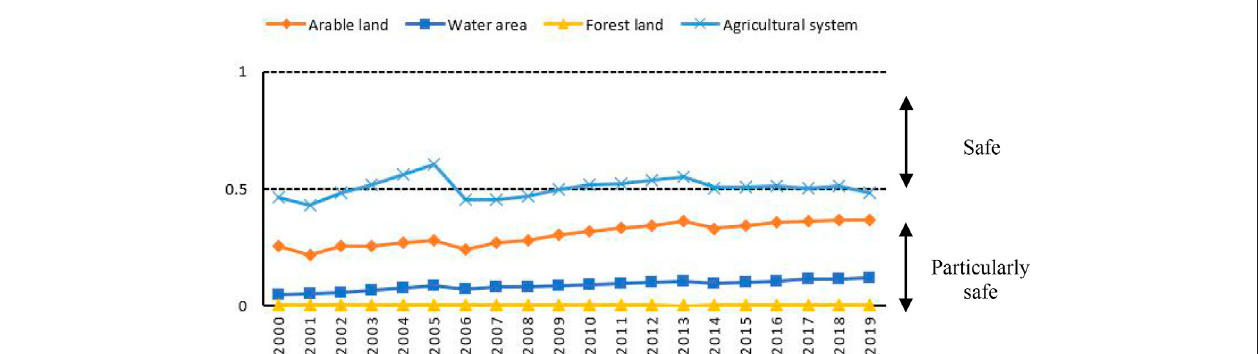
Frontiers in Environmental Science |